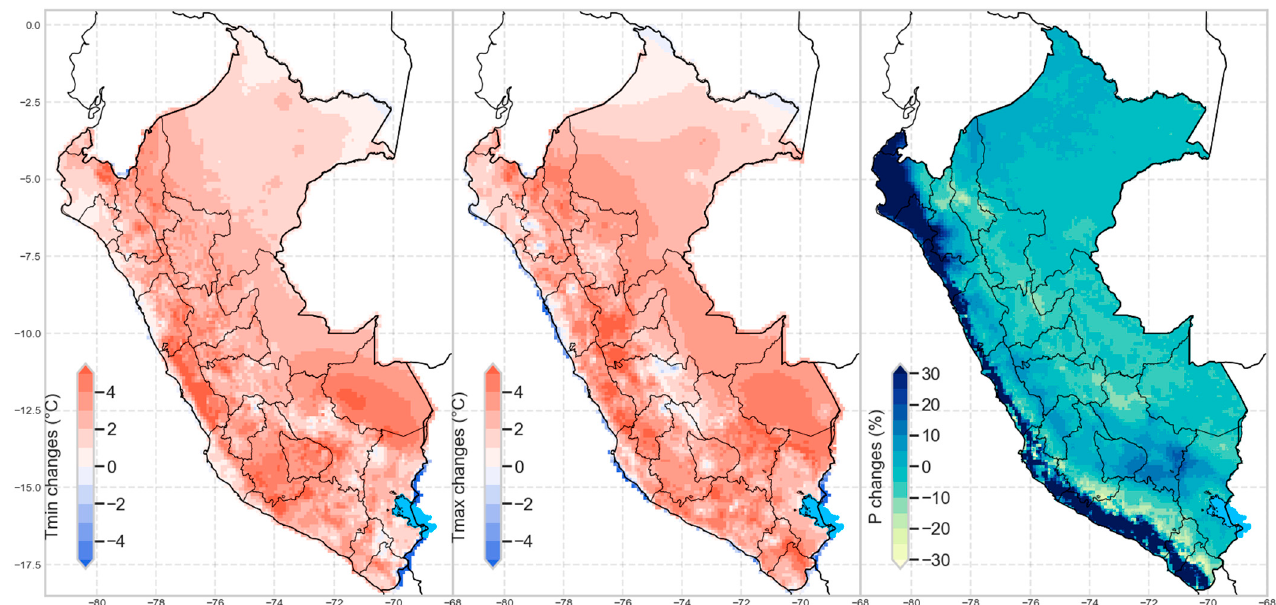
Figure A1. Average absolute (temperature) and percentage (precipitation) change between present (1981–2010) and future (2035–2065) using climate change scenarios.